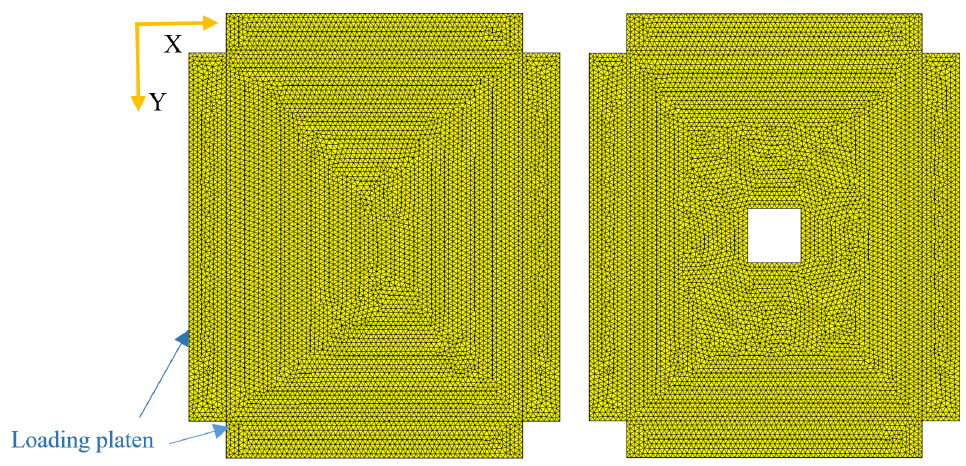
Figure 14. The lateral pressure coefficient λ increases from 0.1 to 1.35 under biaxial loading. The lateral pressure coefficient is for the intact specimen. The vertical stress should be maintained at 16.9 MPa, then the corresponding horizontal stress is calculated according